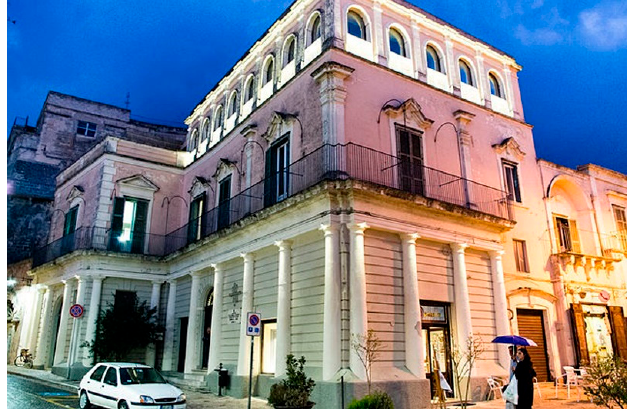
Figure 3. “Ridola” building.